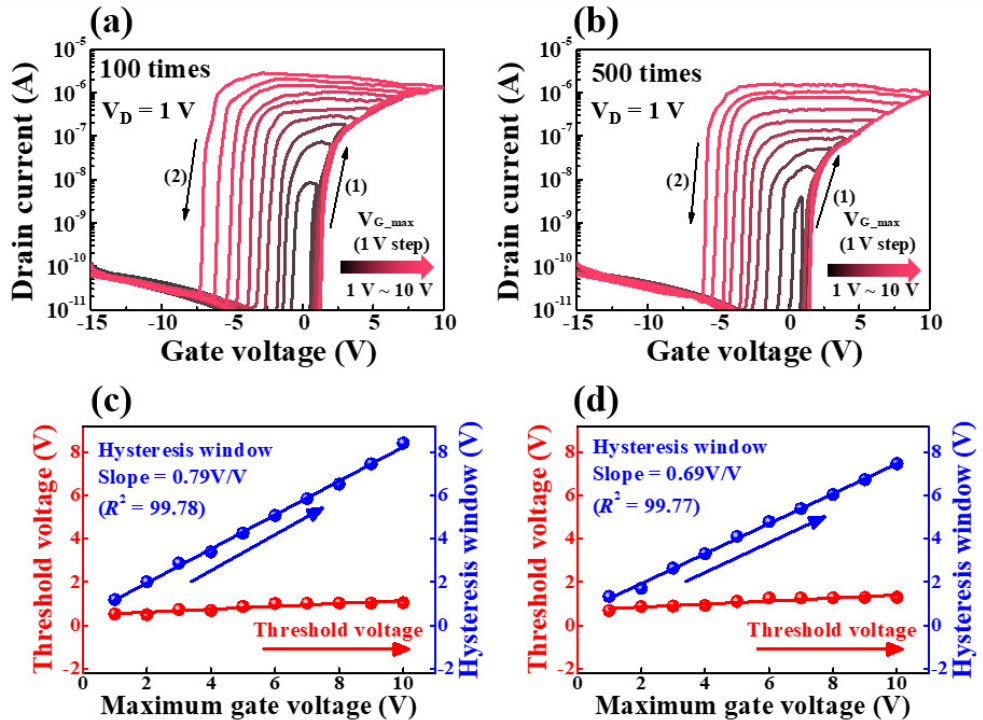
Figure 10. Double−sweep transfer curves as a function of V G_max after bending ( a ) 100 times and ( b ) 500 times to 3 mm. Hysteresis window and threshold voltage characteristics as a function of maximum gate sweep voltage after bending ( c ) 100 and ( d ) 500 times to 3 mm.